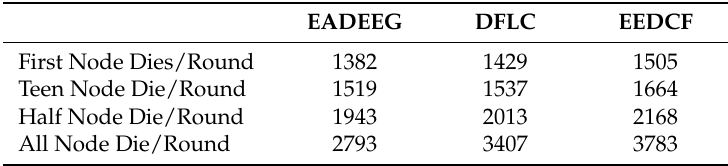
Table 4. Death time of nodes in some specific time points in Scenario 1.